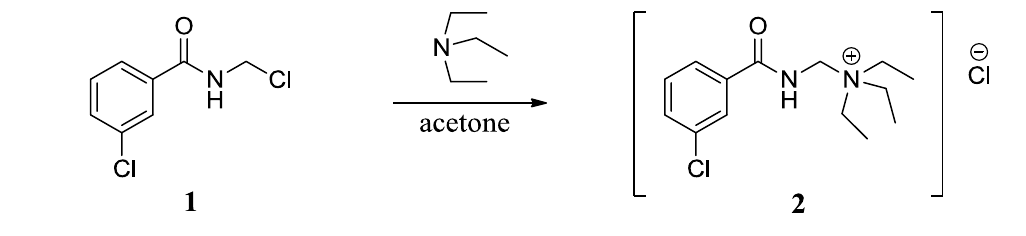
Figure 1. Reaction scheme of the title